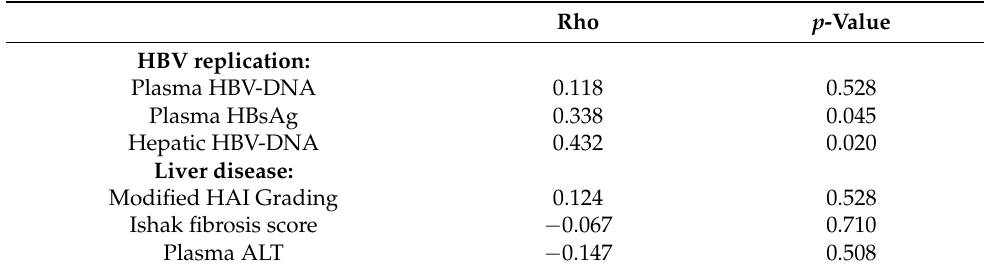
Figure 3. Hepatic HBV-miR-6 expression levels in CHB patients. HBV-miR-6 expression levels were measured in liver tissue derived from 87 CHB patients and 13 HBV negative controls using qPCR. Relative expression levels of HBV-miR-6 were normalized to GAPDH expression using the 2^−ΔCt method; the data are presented as a boxplot and whiskers. Table 2. Correlations between hepatic HBV-miR-6 expression levels and biomarkers of HBV activity and liver damage.